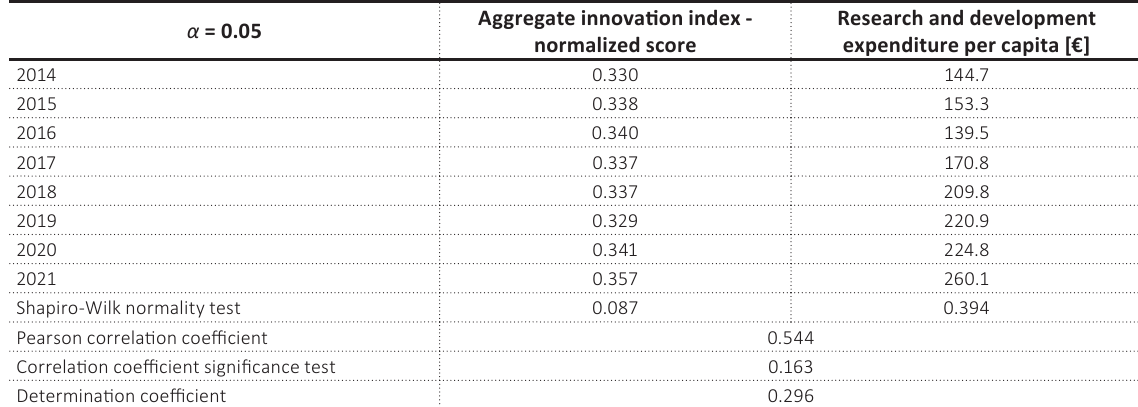
Table 4. Test statistics – Hungary